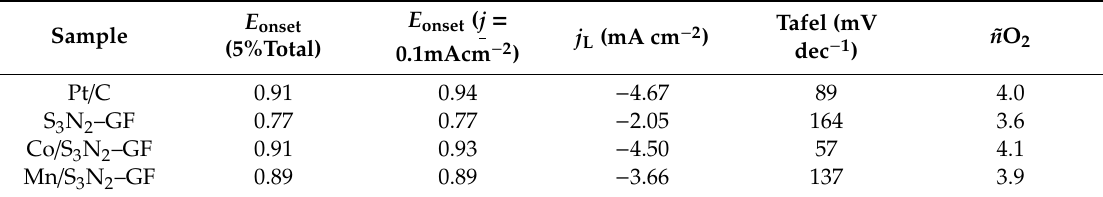
Table 1. Onset potentials ( E onset ), di ff usion-limiting current density values ( j L,0.26 V,1600 rpm ) and Tafel slopes determined from the ORR LSV curves in 0.1 mol dm − 3 KOH and the number of electrons transferred for each O 2 molecule.